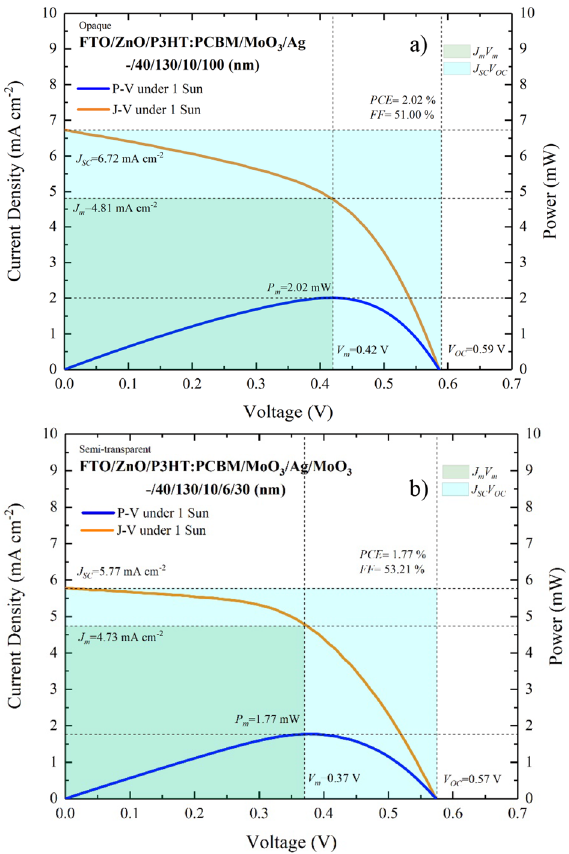
3 /Ag (–/40/130/10/100 nm) opaque-OSC